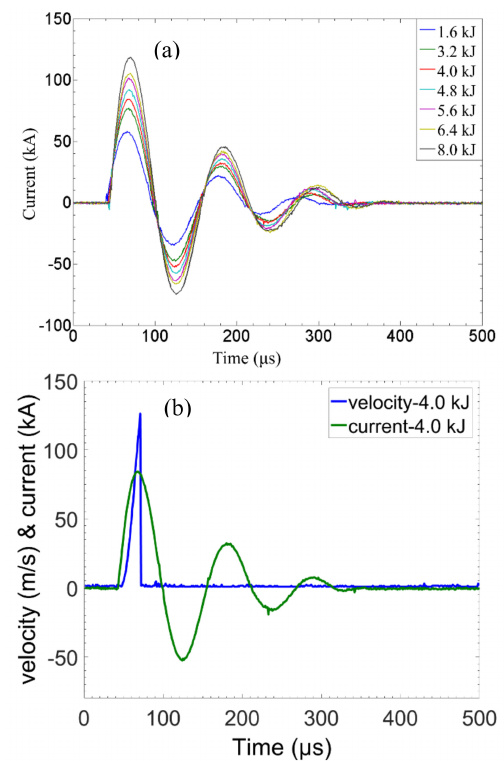
Figure 10. ( a ) The primary current for Ti bipolar plate forming with Cu110 as the driver at capacitor bank energies of 1.6 kJ, 3.2 kJ, 4.0 kJ, 4.8 kJ, 5.6 kJ, 6.4 kJ, and 8.0 kJ and ( b ) the primary current